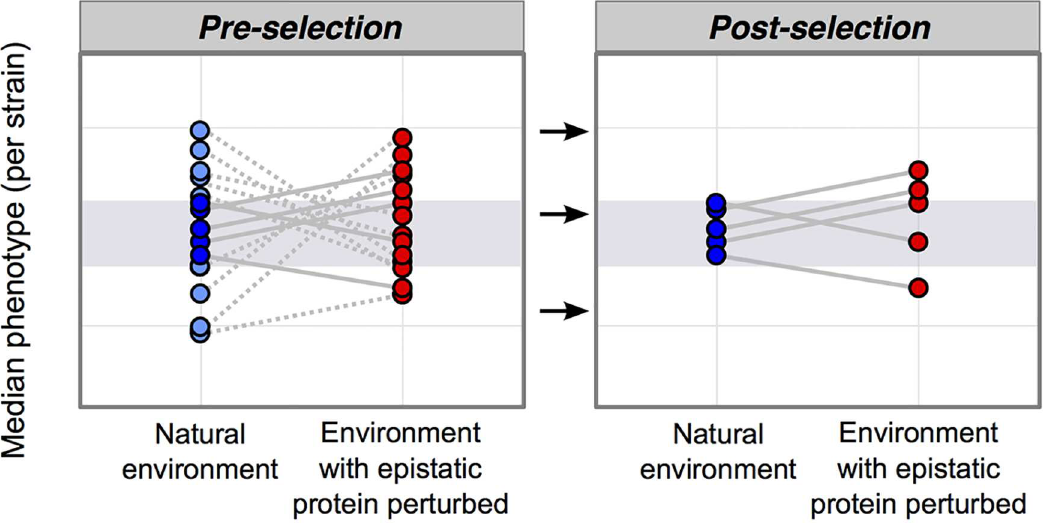
Fig 6. A model of how selection transforms the epistatic landscape, enriching for buffering. This model is schematized similarly to Fig 4A. Pre-selection: inhibiting an epistatic protein has genotype-specific effects on phenotype that result in line crossing. Stabilizing selection will narrow the amount of phenotypic diversity in the natural environment, removing genotypes with extreme phenotypes (light blue circles that fall outside of the grey shaded area). Removing these genotypes from the plot entirely (removing the light blue circles, dotted lines, and connected red circles) results in the post-selection plot. Post-selection: inhibiting an epistatic protein may reveal phenotypesoutside of selection’s sieve (grey shaded